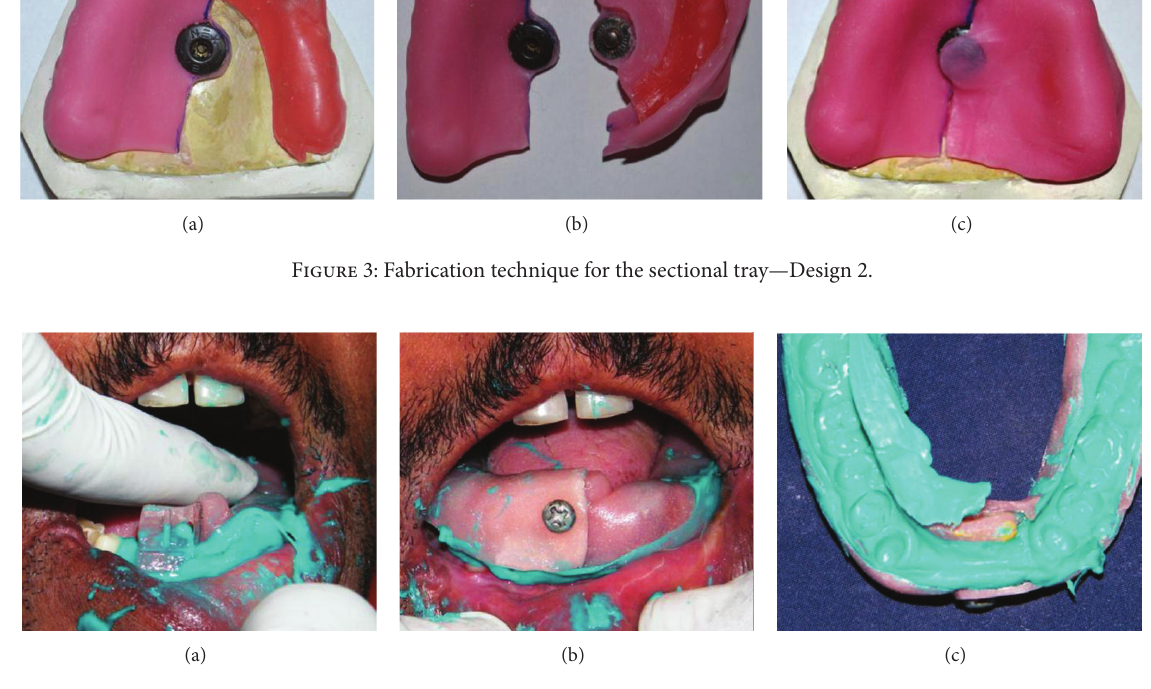
Figure 4: Impression making using the sectional tray Design